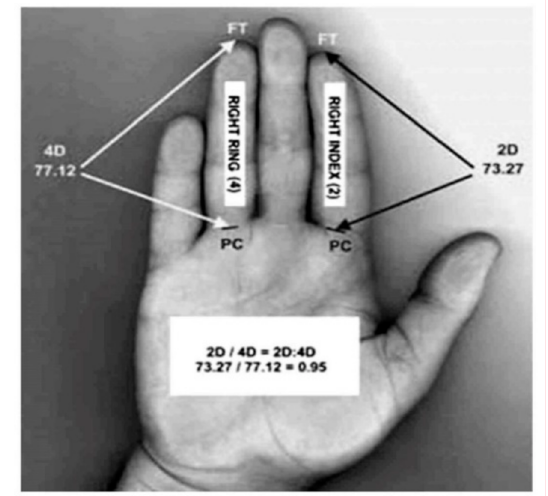
Figure 1. Measurement and calculation of the second to fourth digit (2D:4D)